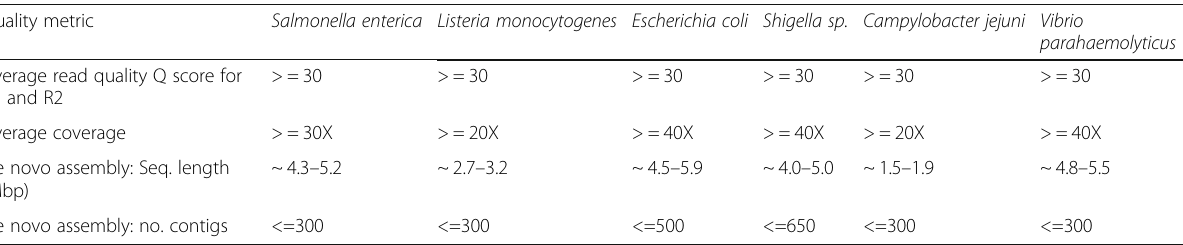
Table 1 Quality control threshold guidelines for enterica pathogens collected for GenomeTrakr Quality